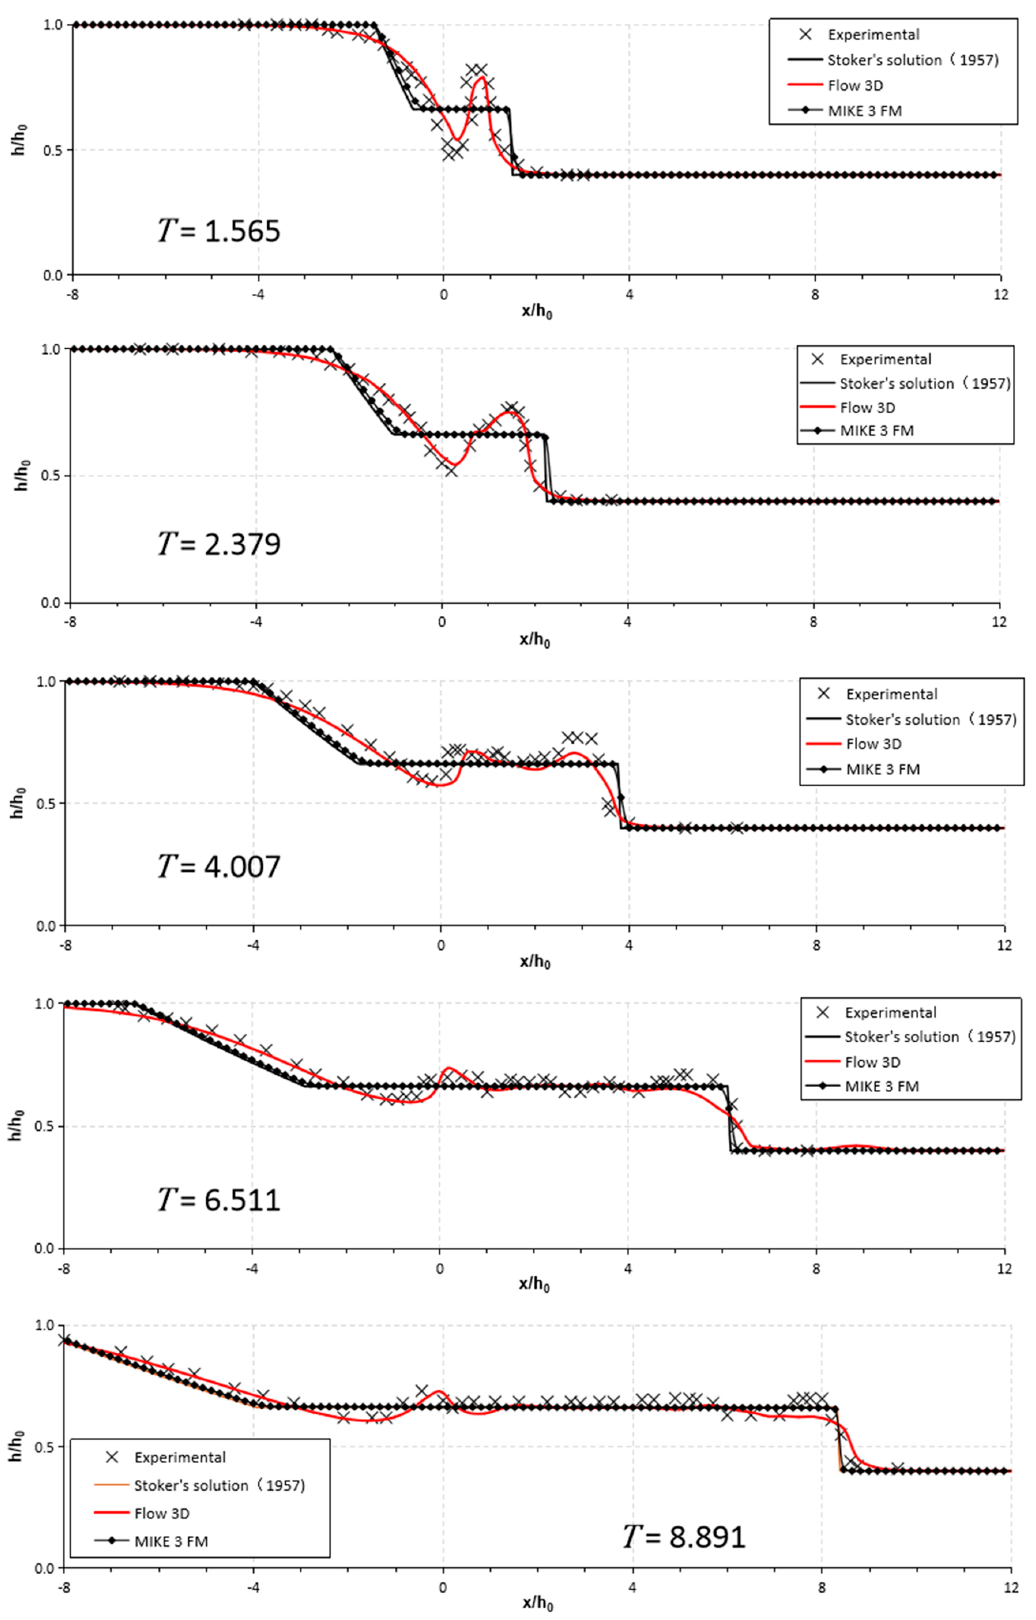
Figure 8. Comparison between observed and simulated free surface profiles at dimensionless times T = t ( g / h 0 ) 1/2 and for the wet-bed ( α = 0.4). The experimental data are from Reference [30].